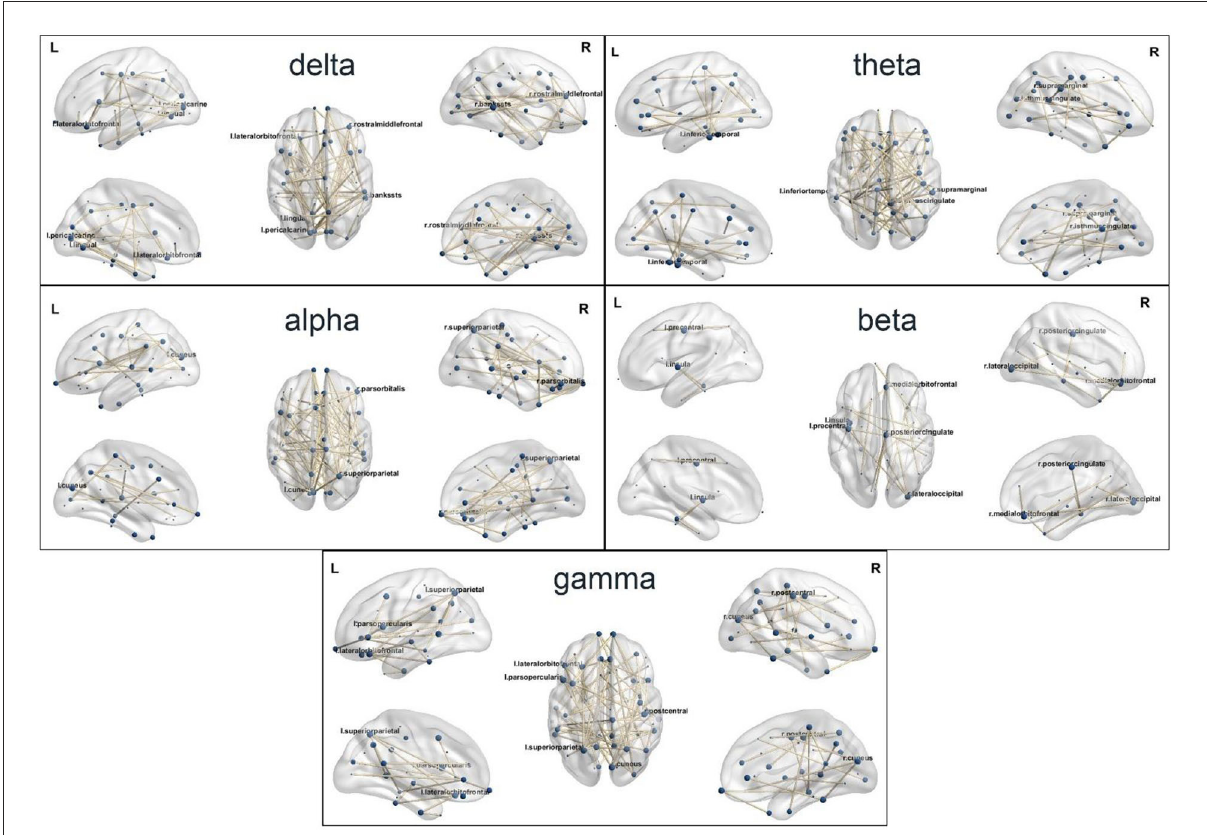
FIGURE3 The source-level brain networks of cognitive reappraisal in five frequency